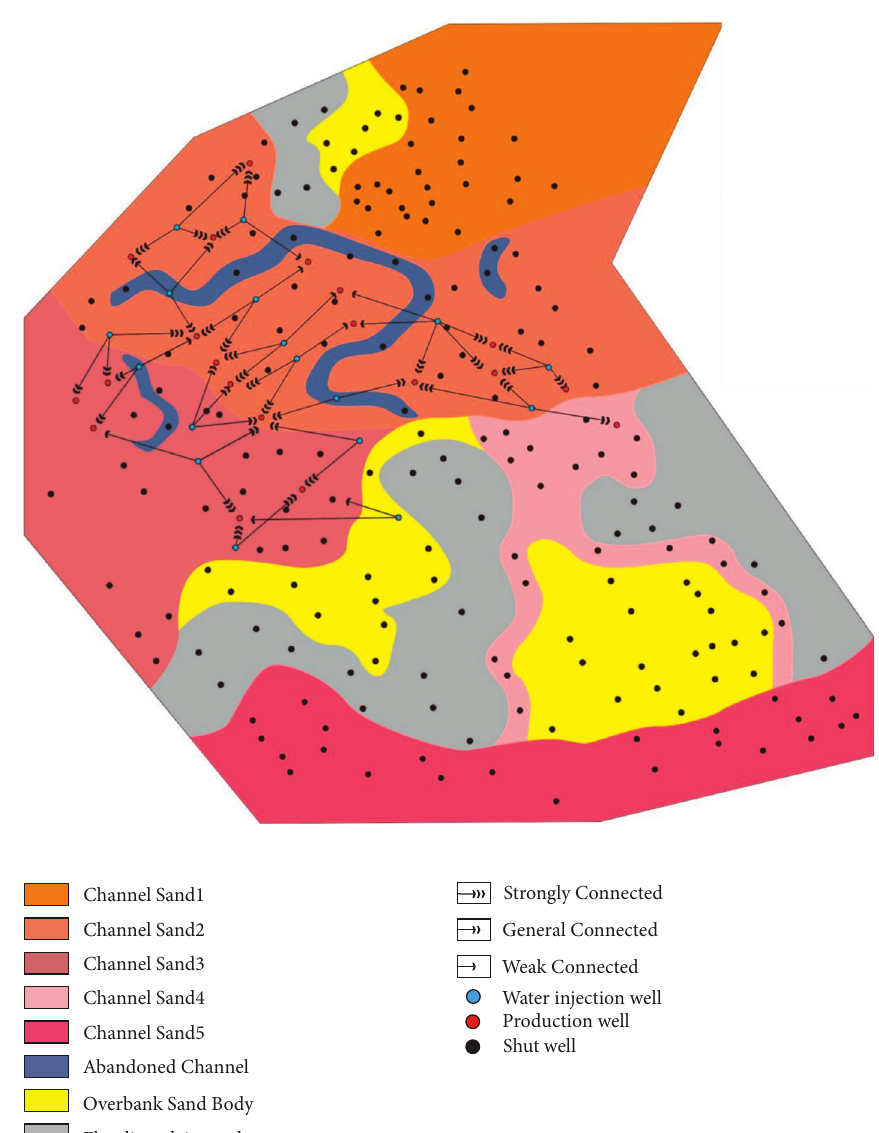
Figure 7: Intensity diagram of the injection-production relationship under planar seepage